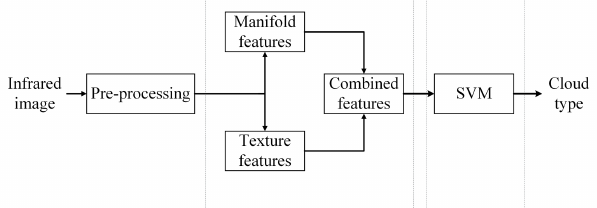
Table 2. The numbers of each class on two